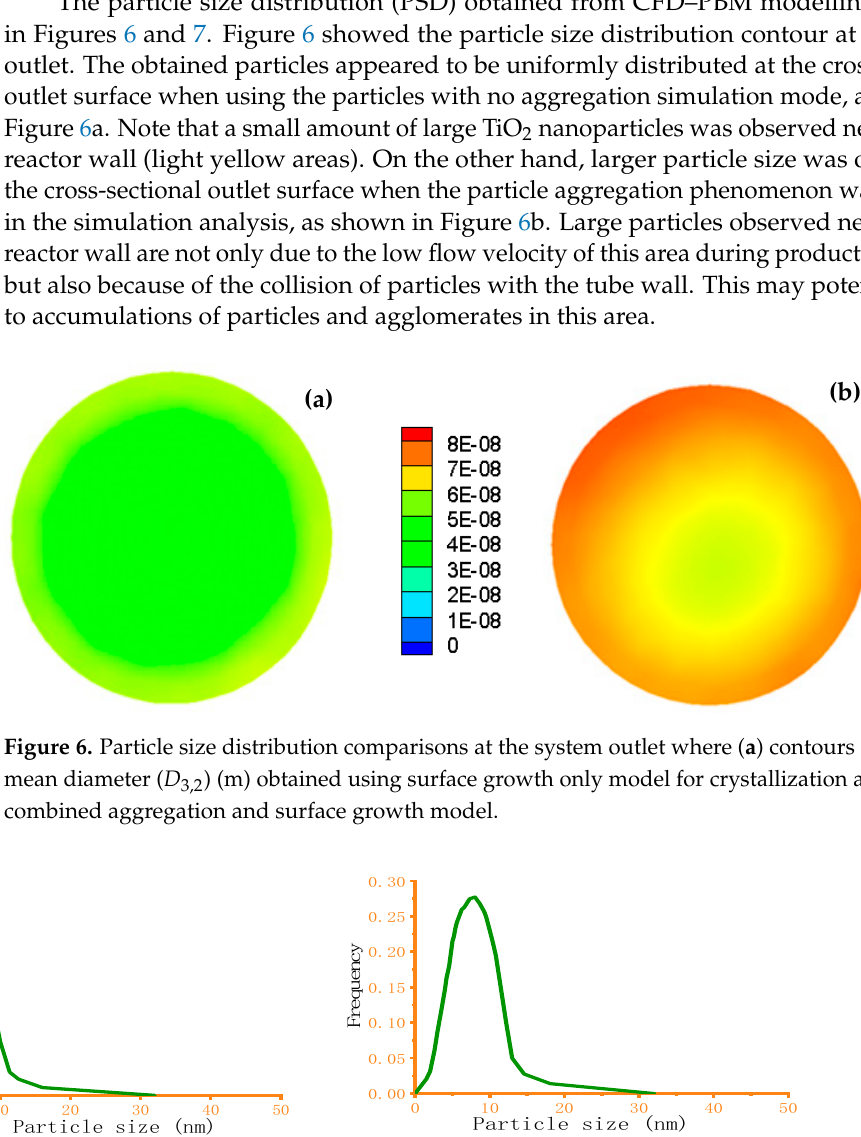
Figure 7. Comparison of ( a ) length number diameter distribution ( D 1,0 ) (m) obtained using surface growth only model for crystallization and ( b ) using combined aggregation and surface growth model.